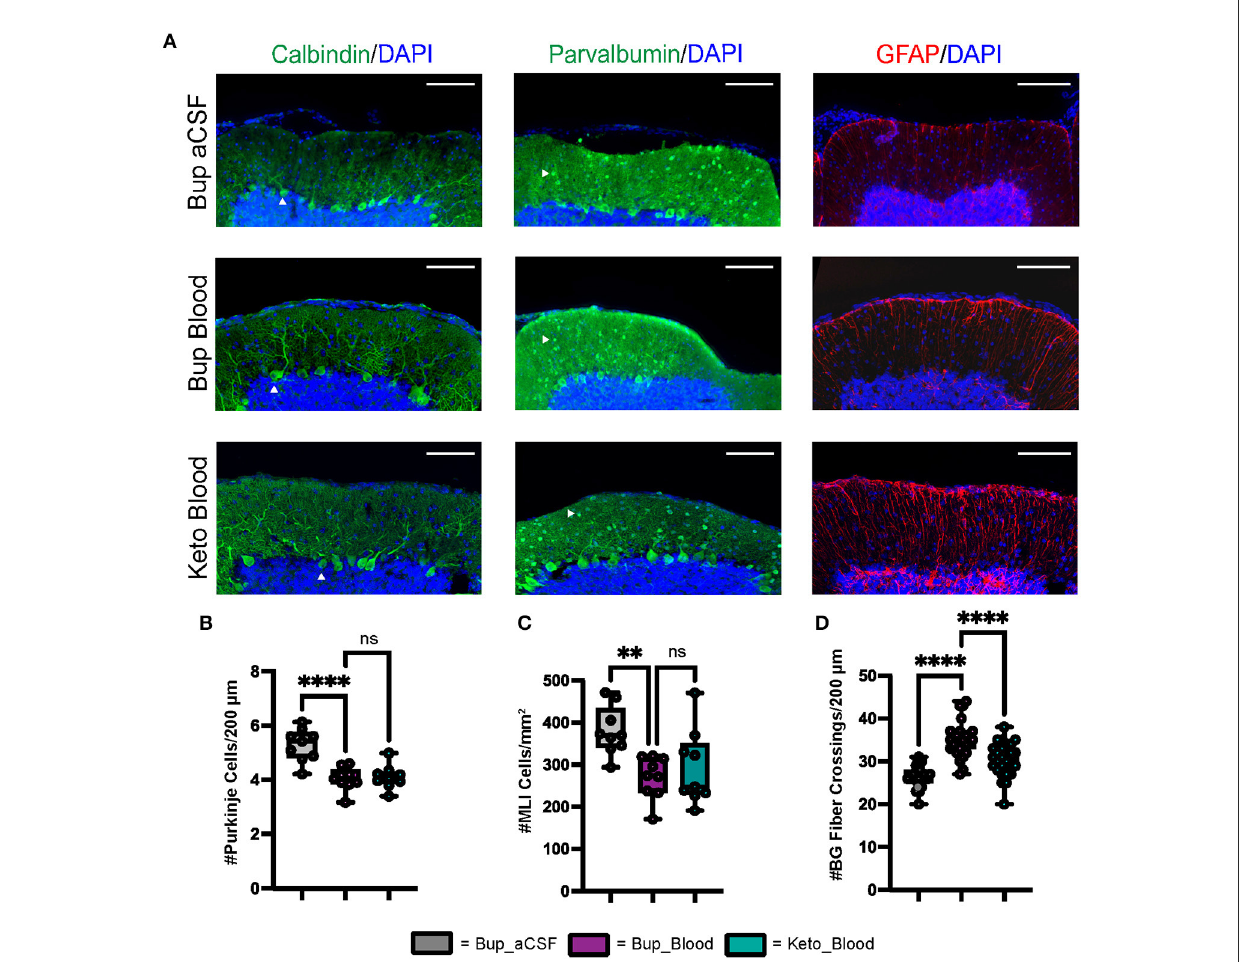
FIGURE2 CHI results in decreased PC density, decreased MLI density, and increased BG fiber crossings within the ML at P42. (A) Representative confocal images at 20X demonstrating difference in PC (white arrowhead) density (left), MLI (white arrowhead) density (middle), and BG fiber density and morphology (right). Scale bars are 100 µ m. (B) Quantification of PC density in lobule VI-X for all treatment groups ( N = 3, n = 9). (C) Quantification of MLI density in lobule VI-X for all treatment groups ( N = 3, n = 9). (D) Quantification of BG fiber crossings within the ML for all treatment groups ( N = 3, n = 27). Significance defined as p < 0.05 by one-way ANOVA with Tukey’s post-test. Data are presented as SEM with minimum and maximum values. N = number of animals per group included for analysis, n = number of section segments per group included for